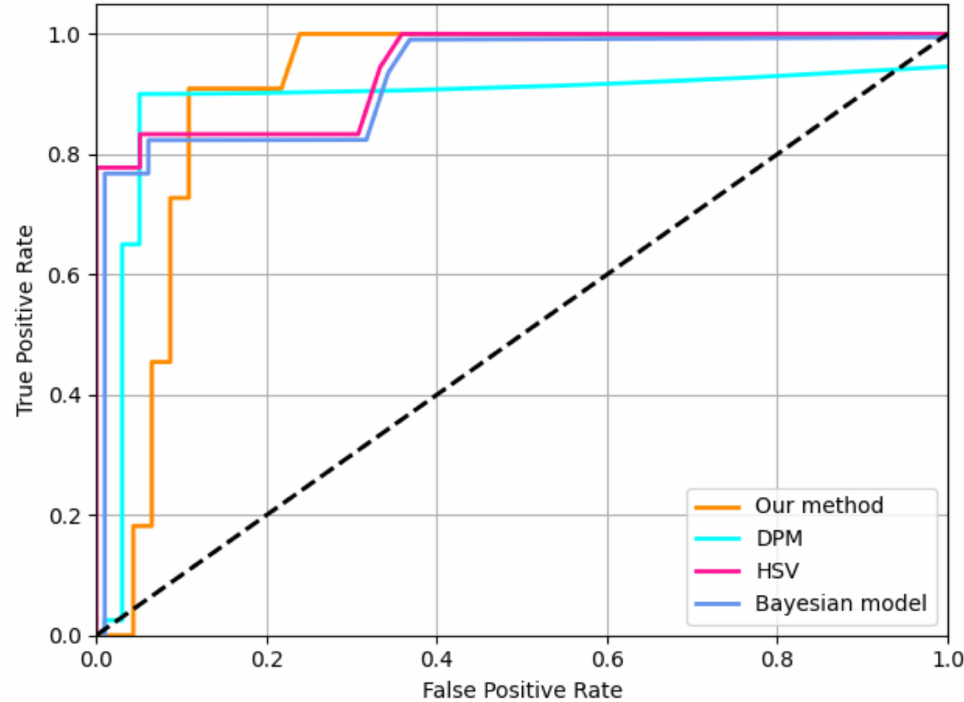
Figure 8. ROC curves of Bayesian attention model, DPM model, skin-color-based HSV model, and the proposed